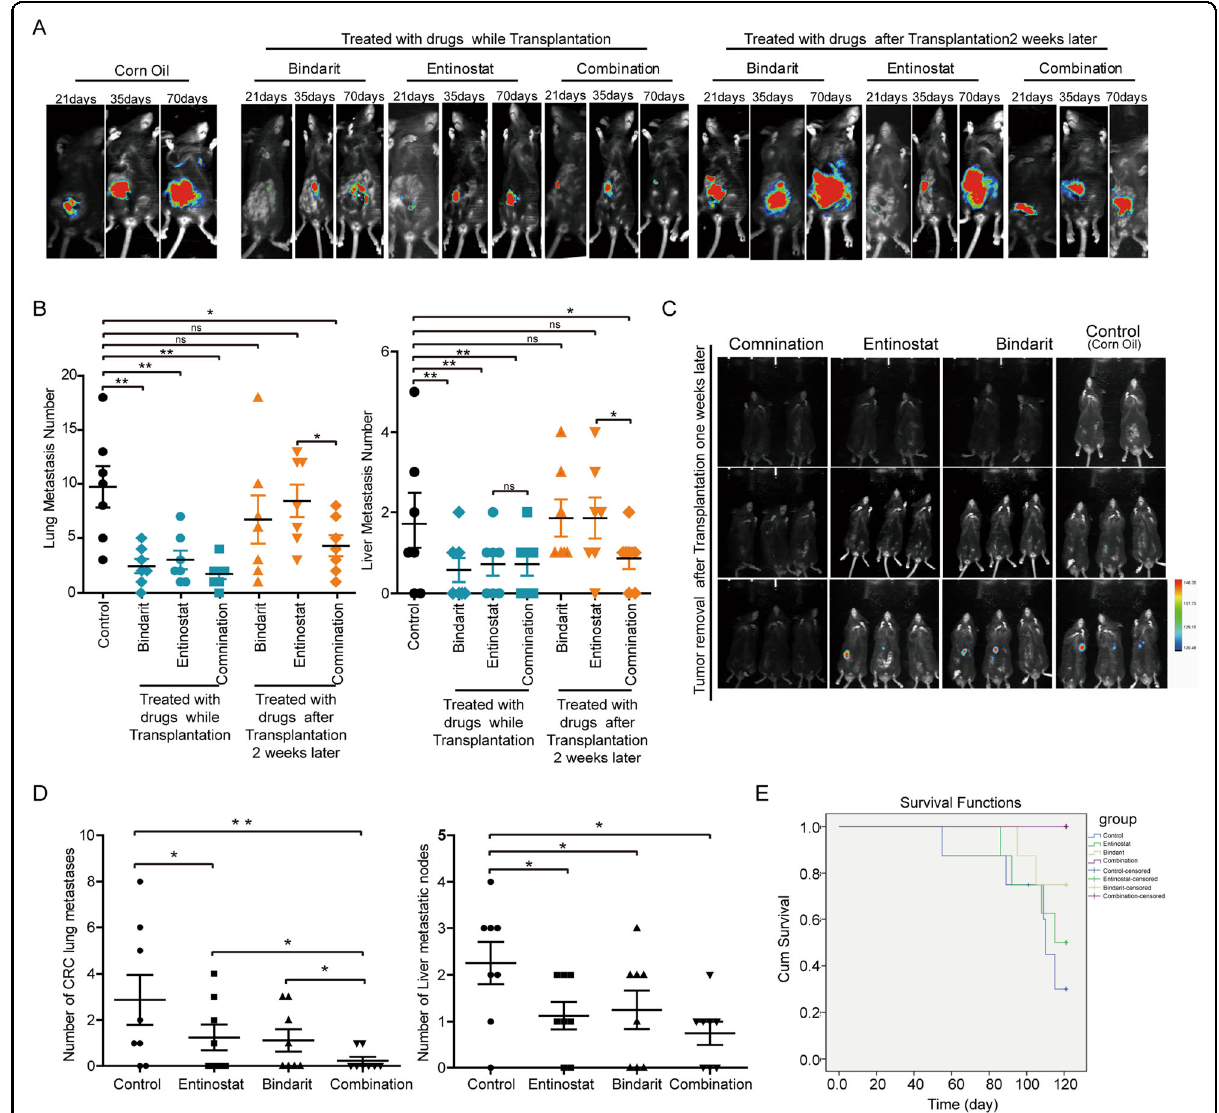
Fig. 6 CCL7 inhibitor reduced CRC macro-metastases and prolonged survival in mice. A Effect of CCL7 inhibitor Bindarit and MDSC inhibitor Entinostat on the CRC metastasis was observed by Bruber In Vivo MS FX Pro Imager. B Quantities of the metastases nodes in CRC mice were observed by light microscope. C The receiving primary tumor resection CRC mice were treated with CCL7 inhibitor Bindarit or MDSC inhibitor Entinostat, and their metastases were observed by Bruber In Vivo MS FX Pro Imager. D Quantities of the nodes of metastases in CRC mice treated with primary tumor resection and observed by light microscope. E The survival of mice treated with CCL7 inhibitor Bindarit and MDSC inhibitor Entinostat by Kaplan – Meier